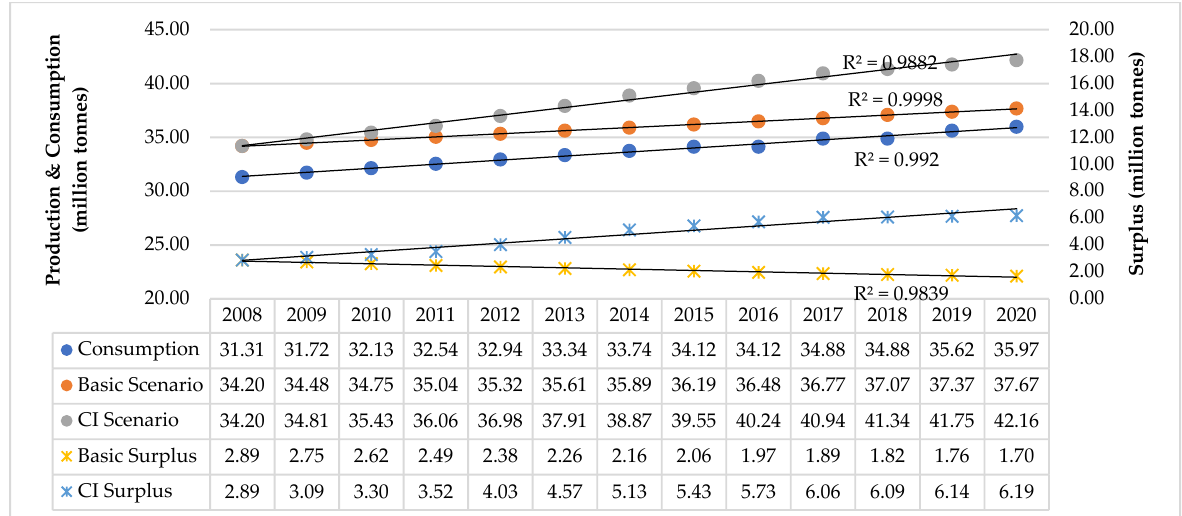
Figure 2. The average productivity of Indonesian rice in 1976–2016.